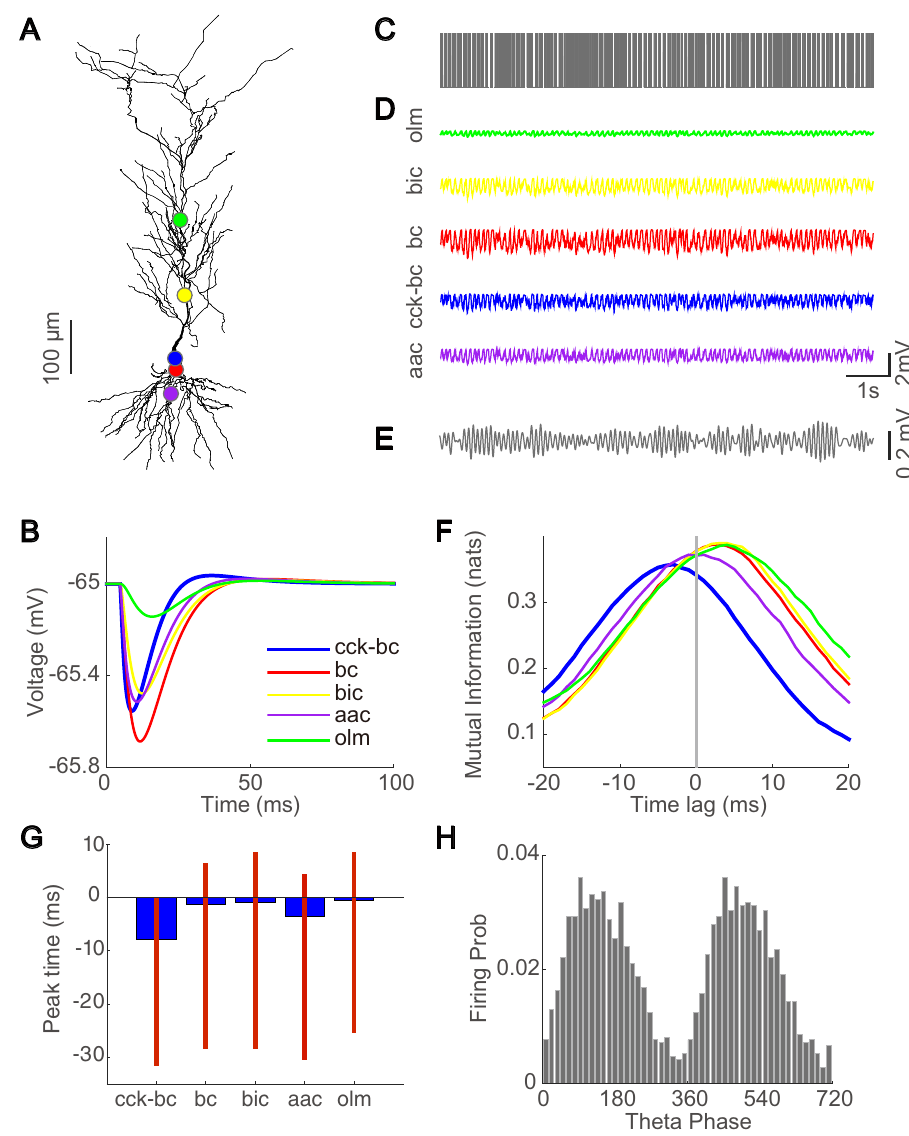
Figure 5. Classification of theta-driving neurons via realistic neuron simulations. ( A ) Morphology of the realistic CA1 pyramidal neuron model. Colored dots indicate the input locations of interneurons–AAC (purple), BC (red), CCK-BC (blue), BIC (yellow), and OLM (green). ( B ) Hyperpolarized somatic voltage trace of the pyramidal neuron in response to an individual input spike from an interneuron of each candidate type. ( C ) A spike train of a theta-driving neuron recorded in the experiment. ( D ) Computationally obtained hyperpolarized somatic voltage trace of the pyramidal neuron in response to the input from an interneuron of each candidate type. In our simulation, we assume that the spike train in C as the input to the pyramidal neuron is from an interneuron of one of the putative types with its input location and synaptic dynamics modeled with the corresponding parameters. ( E ) The theta wave obtained through filtering the LFP signal recorded in the experiment in the presence of the spike train of the theta-driving neuron shown in C . ( F ) Dependence of the time-lag of time-delayed mutual information between the experimentally recorded theta wave in E and the computationally obtained membrane potential induced by an interneuron of each type in D . ( G ) Peak time vs. interneuron type–peak time is the time-lag at which the time-delayed mutual information as a function of time-lag reaches its peak amplitude. Blue thick bars indicate the mean values of the peak time and red thin bars indicate the range of the peak time over 5 theta-driving neurons. ( H ) The firing probability of a theta-driving neuron as a function of the theta phase. In A , B , D , F , colors label different candidate interneuron